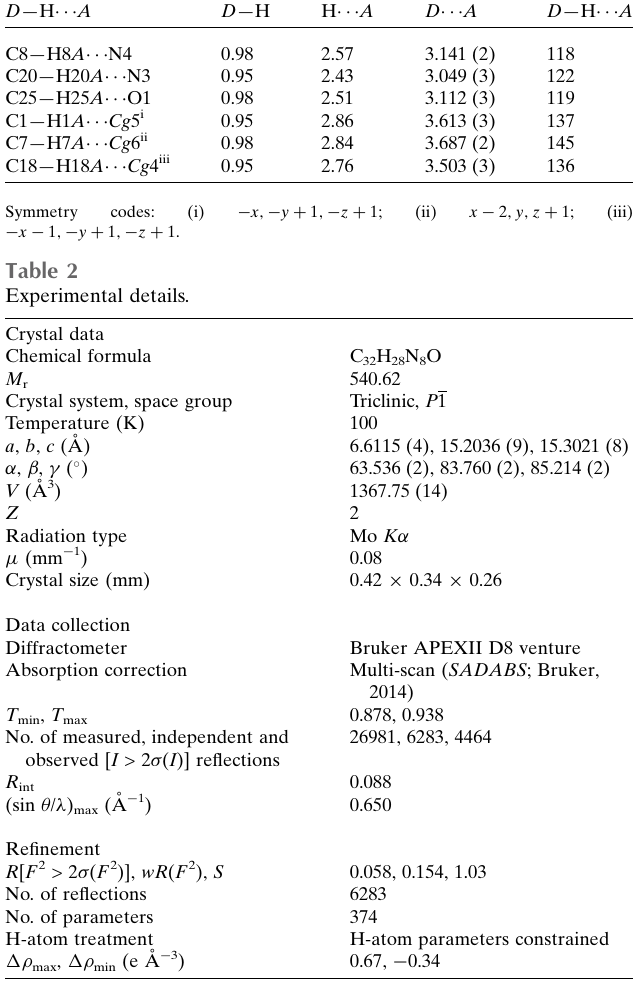
Table 1 Hydrogen-bond geometry (A˚ , (cid:2) ).